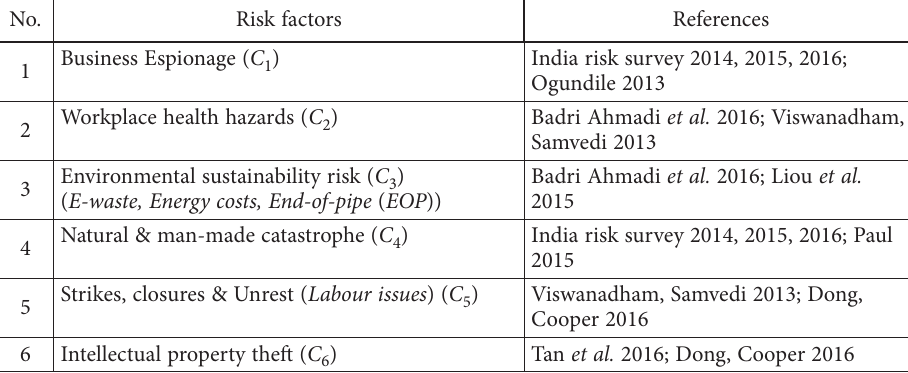
Table 2. Identified risk factors in telecom supply chain